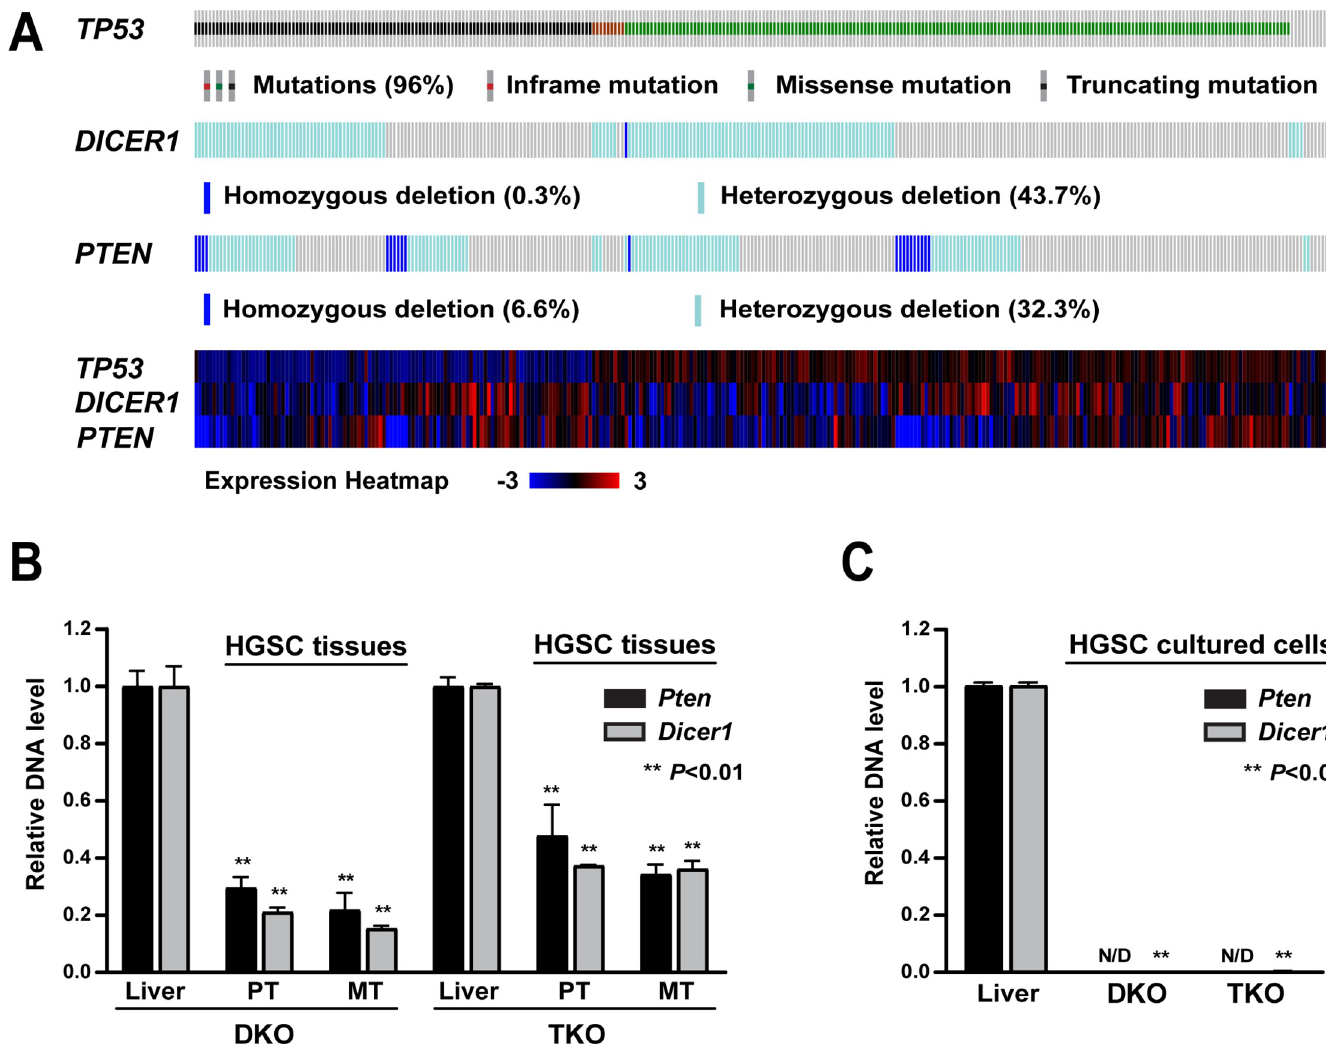
Fig 2. Genetic relevance of mutant p53, Pten , and Dicer1 in human HGSC. A. TP53 mutation as well as DICER1 and PTEN homozygous and heterozygous deletion frequencies in 316 human HGSCs (TCGA, 2011) [14] analyzed in cBioportal [85]. Each column represents an individual patient sample. TP53 is mutated in 96% of HGSC cases, while DICER1 and PTEN hemizygous deletions are detected in 43.7% and 32.3%, respectively. Expression heatmap depicts altered mRNA expression levels of TP53 , DICER1 , and PTEN in corresponding samples. B-C. Quantitative PCR showing the extent of Pten and Dicer1 deletion in (B) primary (PT) and metastatic (MT) HGSC tissues from DKO and TKO mice and (C) cell lines established from DKO and TKO primary HGSC tissues. Two individual HGSC tissues for PT and MT and two HGSC cell lines are used for each model. The DNA levels of Pten and Dicer1 in HGSC tissues and cell lines are measured as fold changes relative to the DNA levels of these genes in liver tissues in DKO and TKO mice. N/D, not